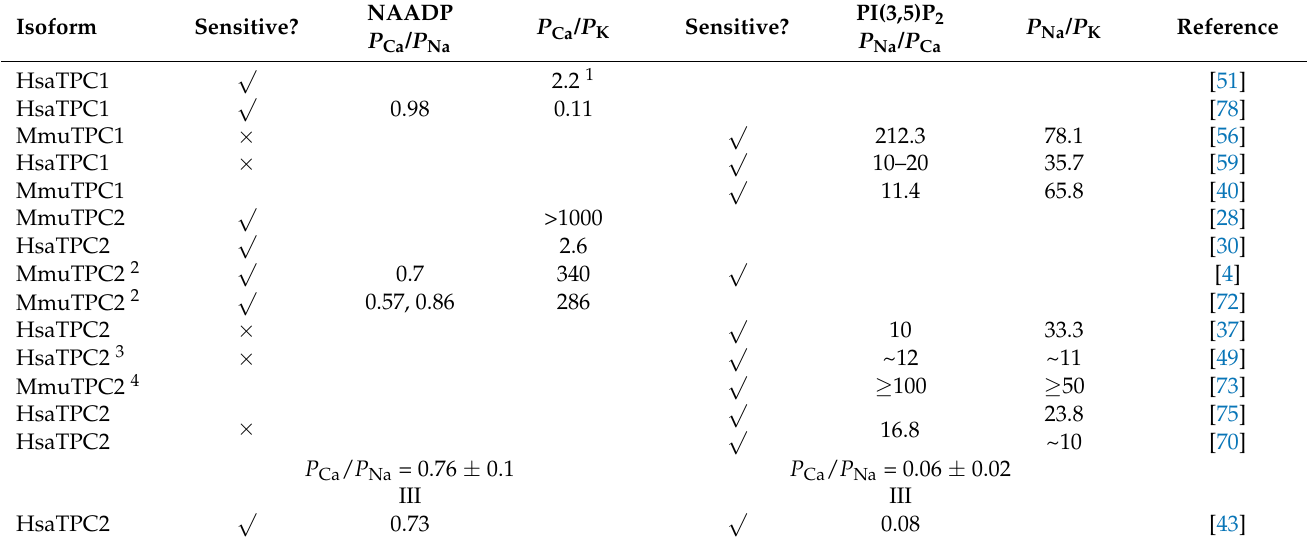
Table 3. Agonist-dependent ion selectivity in TPCs. Reported cation permeability ratios for endolyso- somal TPC1 and TPC2 activated by NAADP and PI(3,5)P 2 . Mean P Ca / P Na values for TPC2 are compared to recent work [43], where the actions of NAADP and PI(3,5)P 2 were assayed in parallel. 1 Ba 2+ used instead of Ca 2+ as the permeant ion. 2 Endogenous activity. 3 Values were calculated on the basis of an estimated reversal potential of − 82 mV (intracellular [Na + ] = 0.2 M, extracellular [Ca 2+ ] = 0.05 M) using the bi-ionic equation in [42] and − 80 mV (intracellular [Na + ] = 0.2 M, extracel- lular [K + ] = 0.1 M) using the bi-ionic equation described in [75]. 4 Recorded from